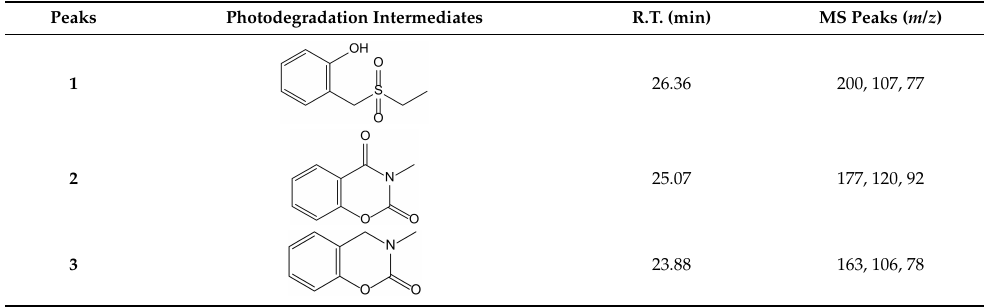
Table 2. Identification of the intermediates from the photodegradation of ethiofencarb by GC/MS.